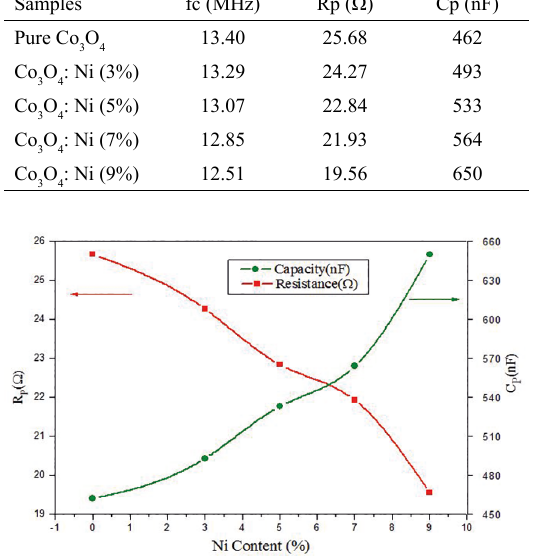
Figure 9. Variation of capacity and resistance of pure and Ni-doped Co O as a function of Ni doping 3 4